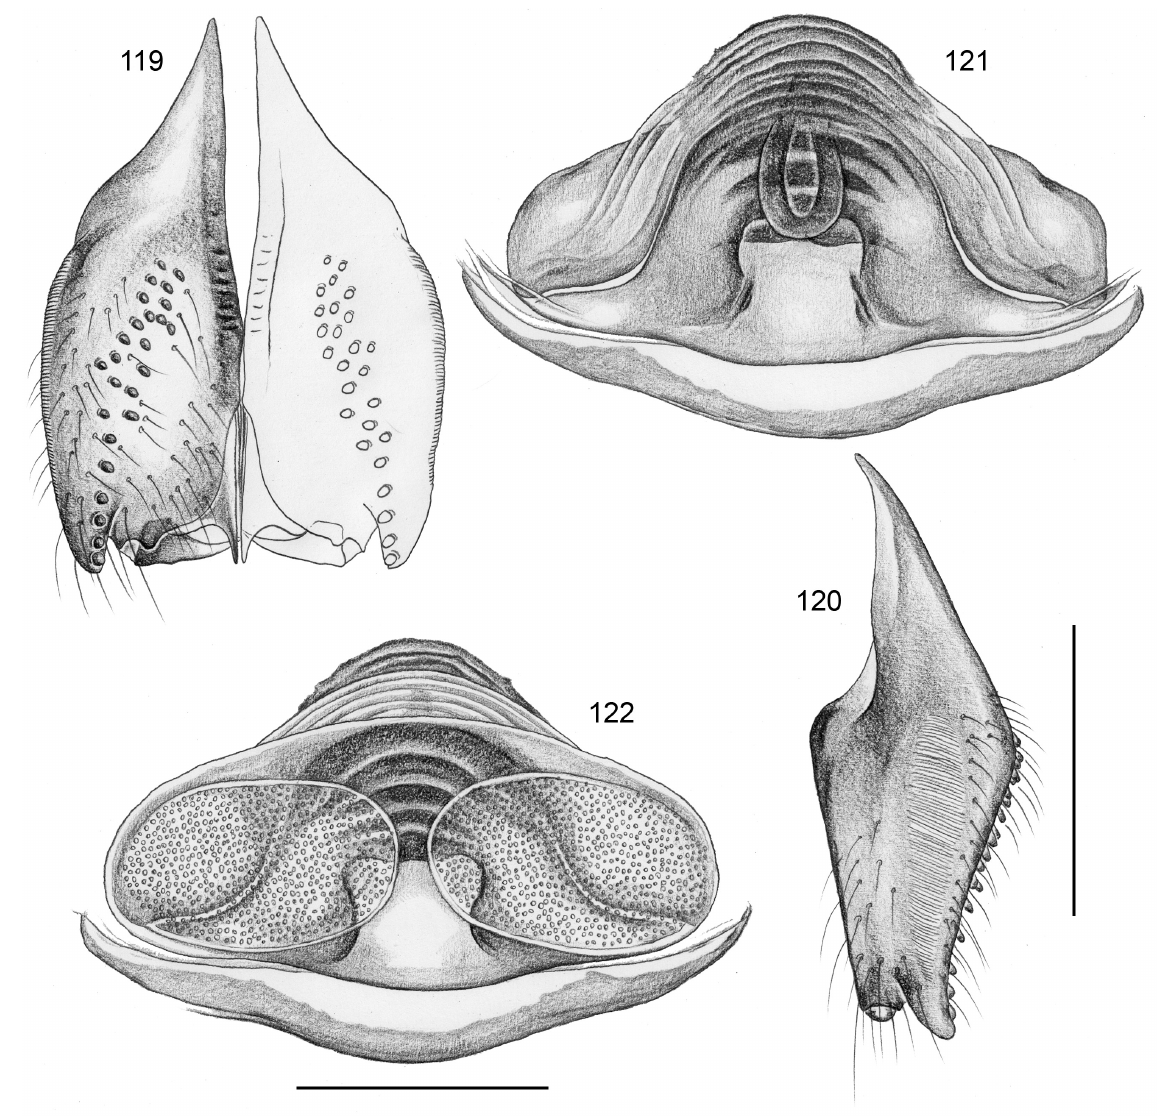
Figs 119–120. Stygopholcus photophilus Senglet, 1971; male from Episkopi, Crete (ZFMK (Ar 22205)), female from Choumerion/Pérama, Crete (MHNG). 119–120 . Male chelicerae, frontal and lateral views. 121–122 . Cleared female genitalia, ventral and dorsal views. Scale bars: 0.5